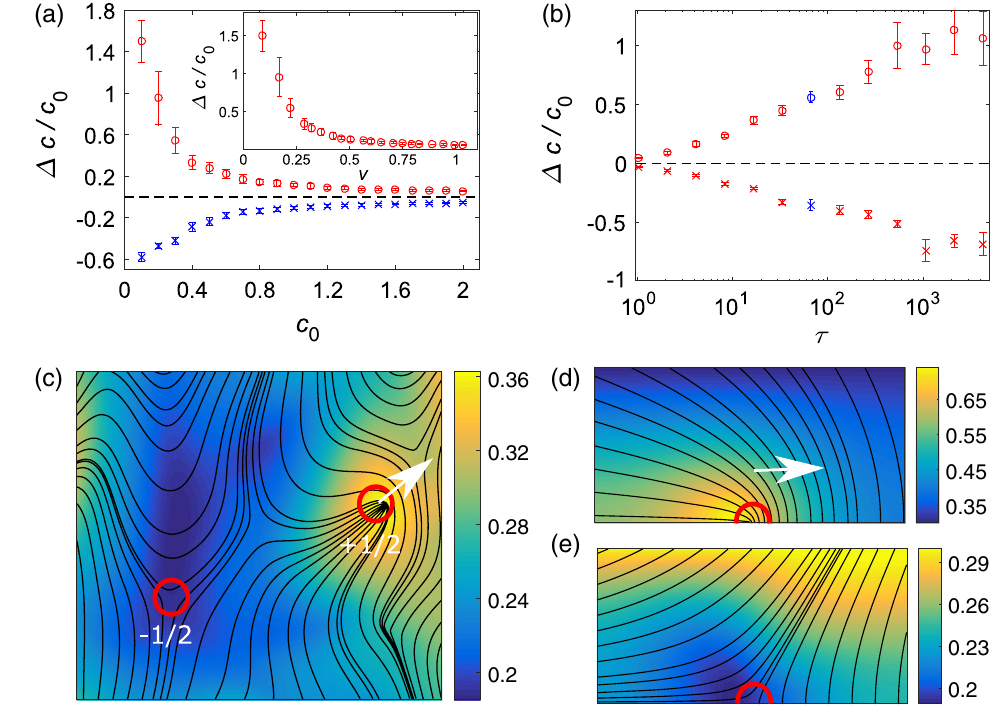
FIG. 4. Concentration distributions. Relative concentration difference Δ c=c 0 vs c 0 for τ ¼ 66 . 6 (a) and vs τ for c 0 ¼ 0 . 3 (b) for 1 = 2 (circle) and − 1 = 2 (times) defects. Inset: Δ c=c 0 for 1 = 2 defects vs defect velocity V . Blue symbols in (b) indicate τ ¼ 66 . 6 used in most of the simulations. Error bars are the standard deviations. (c) Close-up view of the concentration field c for c 0 ¼ 0 . 3 . Some defects are shown in red circles, white arrow indicates the direction of motion. Domain size is 40 × 40 units of length. Steady-state concentration distributions near 1 = 2 defect (d) and − 1 = 2 defect (e) obtained from Eq. (11) for V ¼ 0 . 5 . Size of the integration domain 40 × 20 units; due to reflection symmetry, only the upper half of the field c is